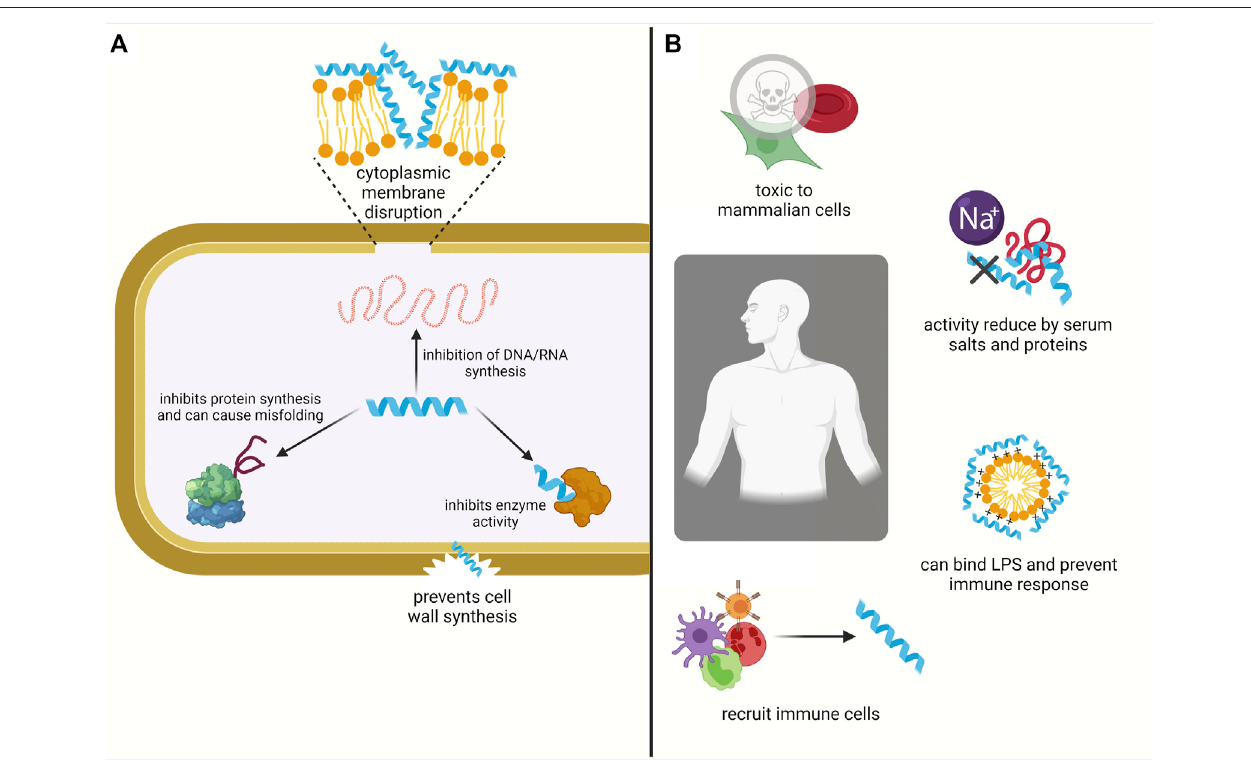
FIGURE1| AMPsinteractwithbothbacterialandmammaliancells.AMPsformamphipathicsecondarystructuresuponinteractionwithbacterialmembrane.They killbacteriabyeitherdisruptingtheinnercytoplasmicmembraneoractingoninternaltargets (A) .Withinthebodytheycanalsopreventin fl ammation,e.g.,bybindingand neutralising thelipopolysaccharides from Gram-negative bacteria and they canmodulate theinnate immune responsebyrecruiting immune cells. However,their activity is reduced under physiological conditions due to the presence of serum salts and proteins and they are susceptible to proteolysis. AMPs can also be cytotoxic towards mammalian cells and exhibit haemolytic activity (B) (Created with